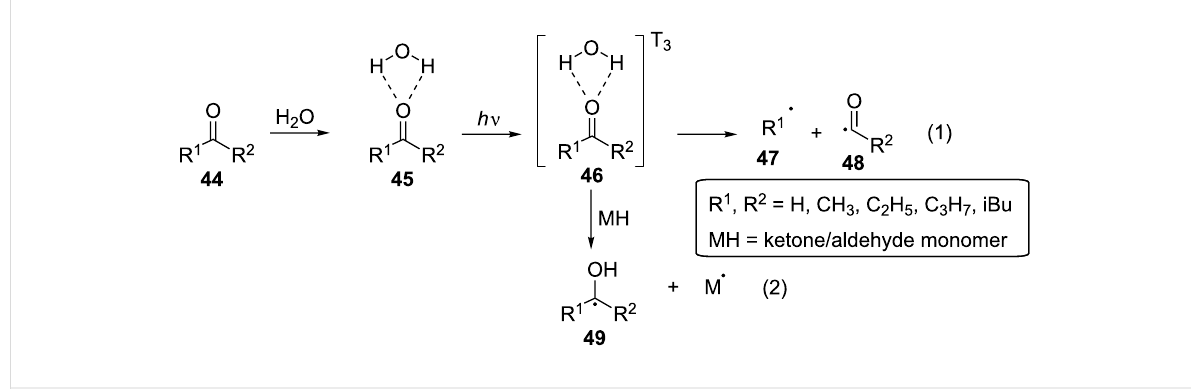
Scheme 12: Proposed photolysis mechanism for aliphatic ketones 44 and formaldehyde ( 35 ).